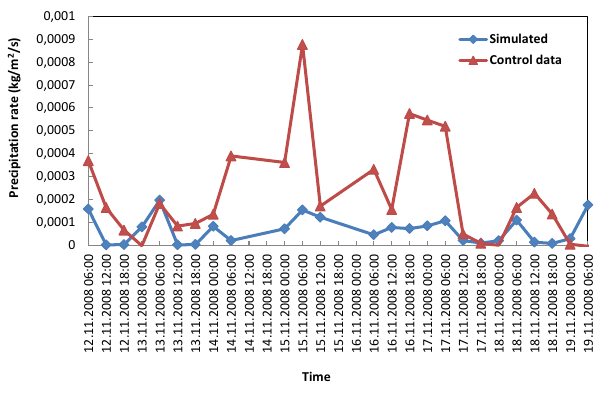
Figure 7. Comparison of best model performance (simulation 4) with control data, for 6-hourly wind-speed prediction during ty- phoon Fig. 7 Comparison of best model performance (simulation 4) with control data, for six-hourly 2